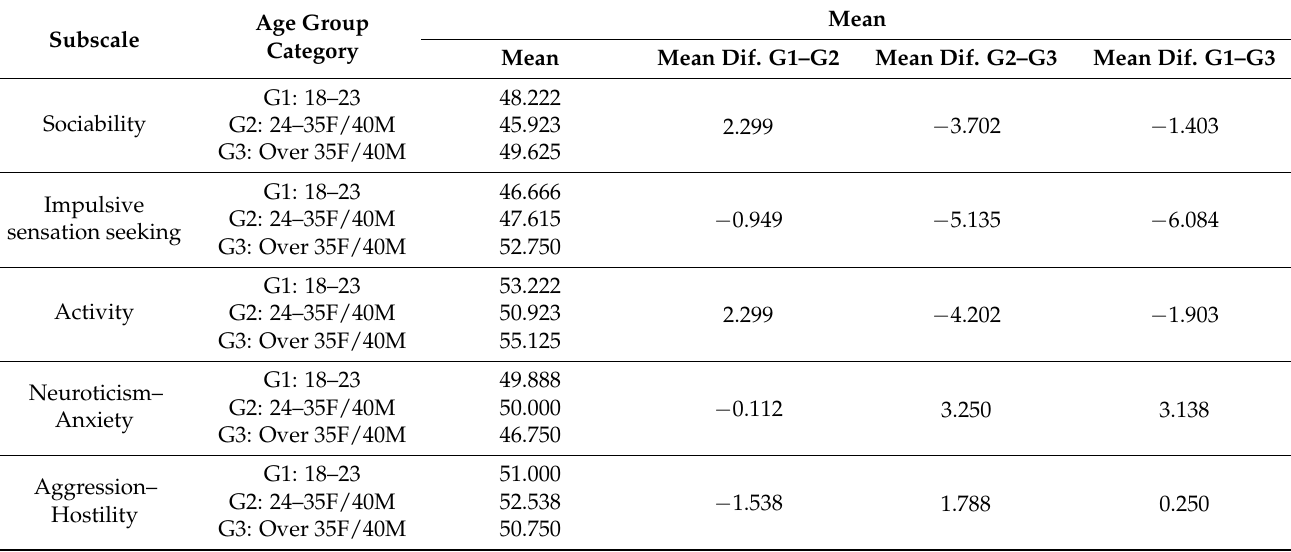
Table 6. Mean differences between groups for the Zuckerman–Kuhlman Personality Questionnaire (ZKPQ)